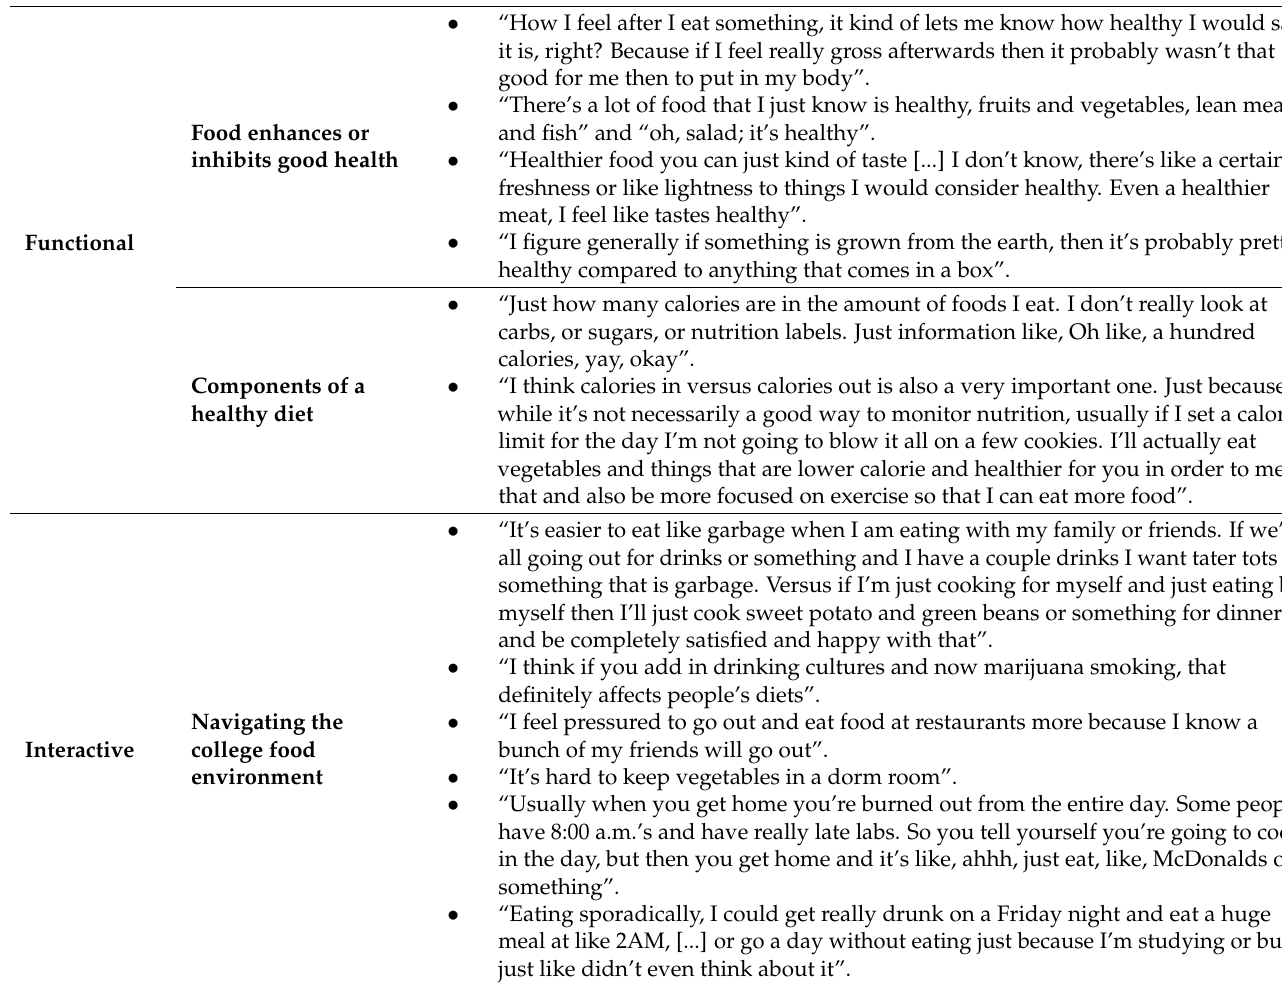
Table 1. Emergent themes and additional supporting quotes organized by nutrition literacy domains.